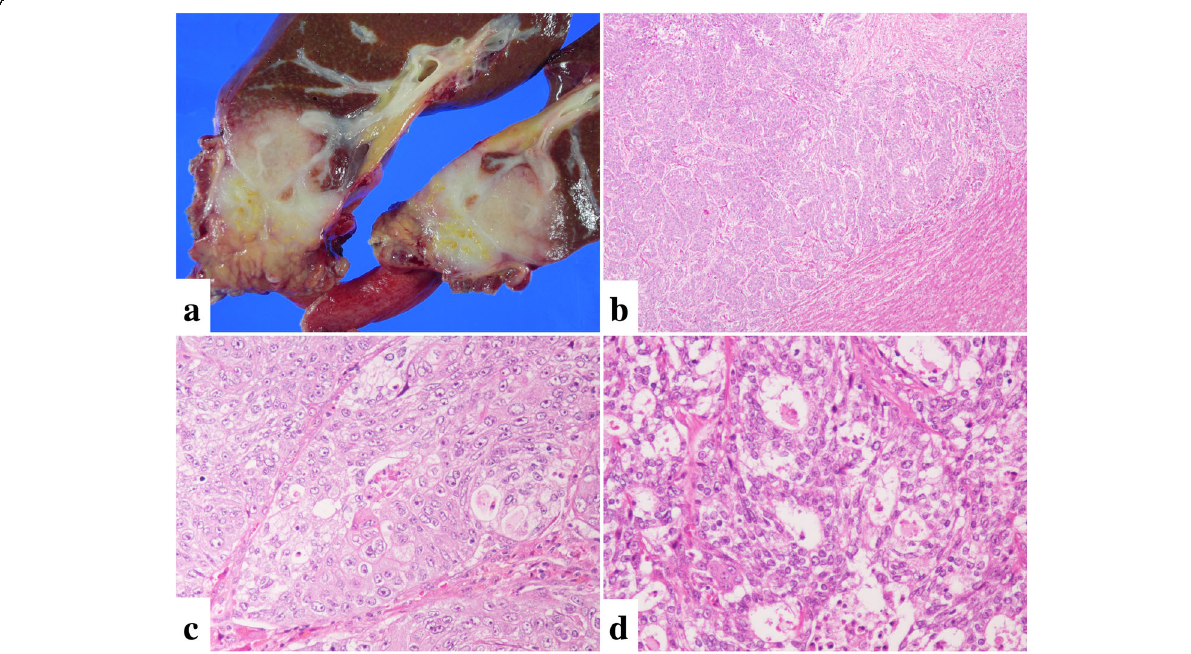
Fig. 1 a : The cut surface of a resected specimen. A whitish solid tumor measuring 5.3 × 3.5 cm in maximal diameter was observed. The tumor showed infiltrative growth around the bile duct, and the border of the tumor was indistinct. The tumor directly invaded the omentum. b-d: Representative histological hematoxylin-eosin (HE) photographs of the tumor. b: The tumor showed invasive growth without capsule formation (HE × 40). c: The tumor partly showed squamous differentiation, including a sheet-like growth pattern, streaming nuclear arrangement, and mild keratinization. These tumor cells were considered squamoid cells. d: Although goblet-like cells were not apparent, a gland-like structure and intracytoplasmic and a small amount of extra-cytoplasmic mucin-producing cells were focally observed (HE ×